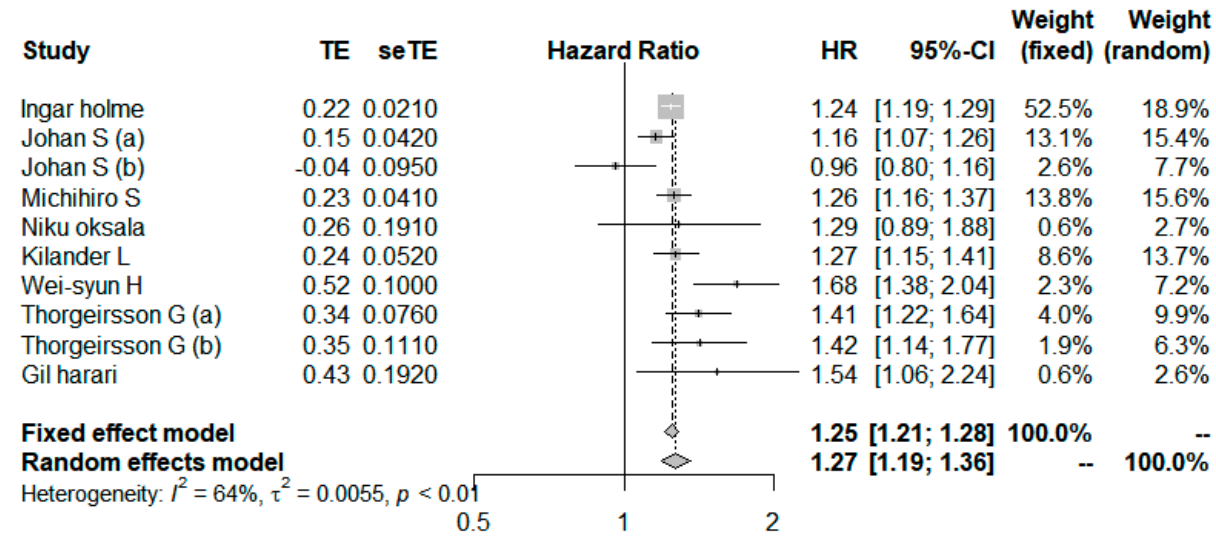
Figure 3. Forest plot for pooled HRs and 95% CIs of CVD mortality for highest versus lowest cate- gories of Serum Total cholesterol (TC) level [23,24,25,27,28,31,32,33]. The overall effect was obtained from a random-effect model.